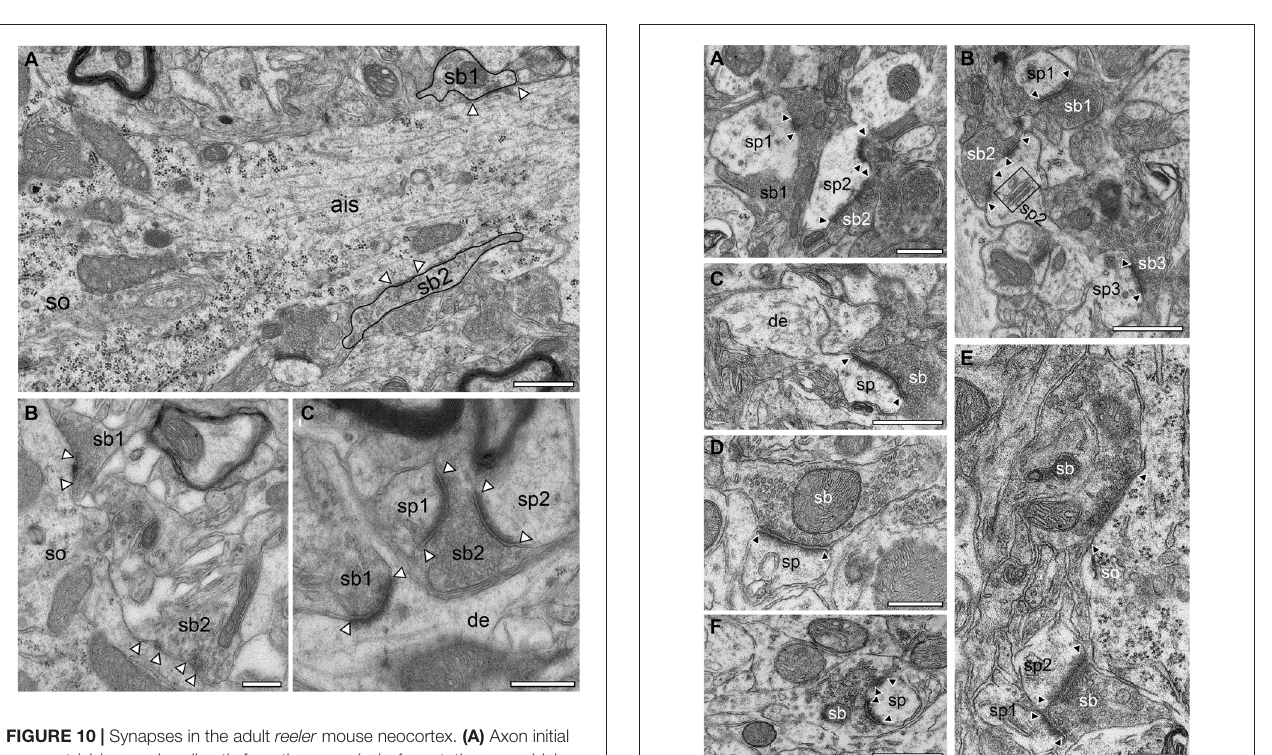
FIGURE 10 | Synapses in the adult reeler mouse neocortex. (A) Axon initial segment (ais) emerging directly from the soma (so) of a putative pyramidal neuron with two terminating synaptic boutons (sb1, sb2, highlighted by black contours). Scale bar 0.5 µ m. (B) Two somatic (so) putative GABAergic synaptic boutons (sb1, sb2) located in the mid part of the neocortical mass, one with two active zones. (C) Two putative glutamatergic synaptic boutons (sb1, sb2) terminating on different targets. Sb1 is located at the emergence zone of a filopodial spine close to the dendrite (de). Sb2 is terminating on two opposing spines (sp1, sp2). Scale bar in (B,C) 2 µ m. In all images, active zones are marked by arrowheads.